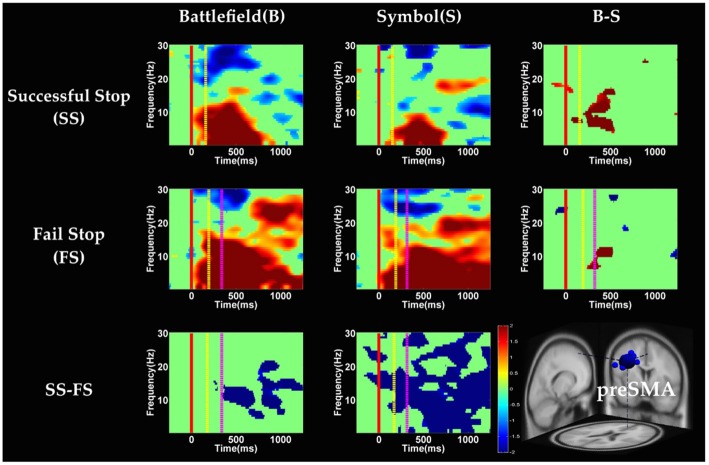
The ERSP images of preSMA cluster under error detection. Red solid line: onset of the go stimulus; yellow dash line: onset of the stop signal; purple dash line: onset of response; color bars indicate the magnitude of the ERSPs; statistical threshold at p < 0.01.